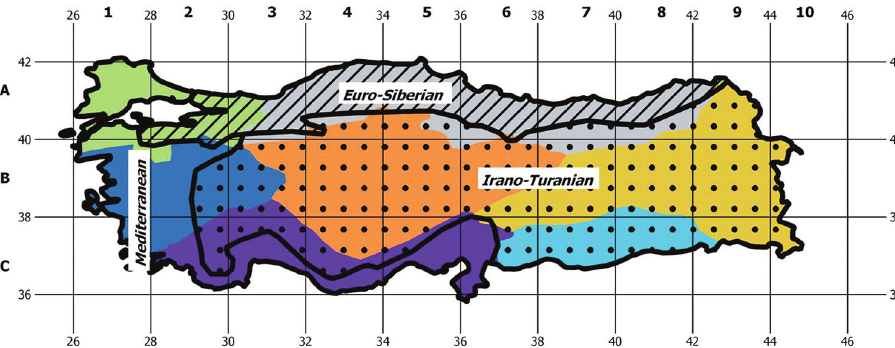
Figure 1. The sections of Turkey in different systems. (i) Biogeographical system: Euro-Siberian – hatch- ing, Mediterranean – no hatching and Irano-Turanian – dots; (ii) geographical system: ■ Marmara region, ■ Black Sea region, ■ Mediterranean region, ■ Central Anatolia region, ■ South East Anatolia region, ■ East Anatolia region, ■ Aegean region and (iii) the grid system according to Davis (1965–1985, 1988) is overlaid over the